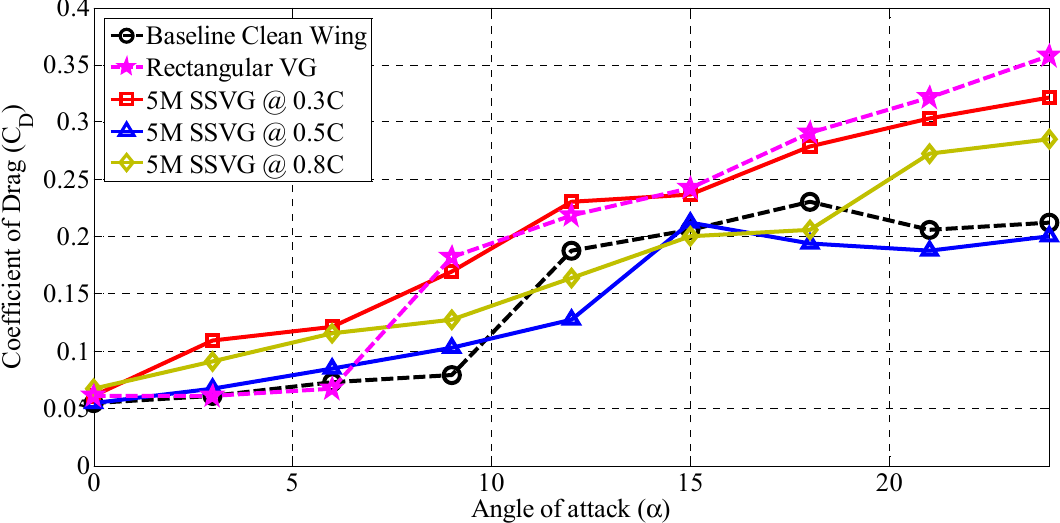
Figure 13. Coefficient of drag ( C D ) vs. angle of attack ( α ) for the baseline and modified model with medium-sized (5M) shark scale vortex generators (SSVG).